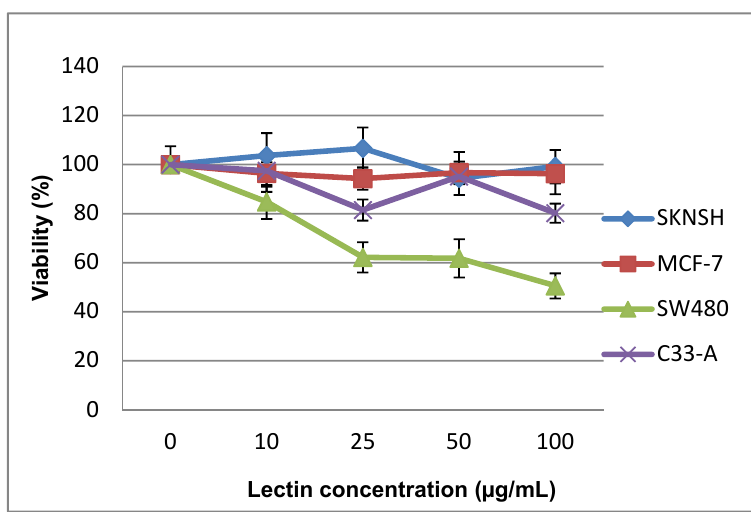
Figure 2. Cytotoxicity of tepary bean lectin (TBL) toward SKNSH, SW480, MCF-7, and C33-A cells after 24 h of exposure employing the 3-(4,5-dimethylthiazol-2-yl)-2,5- diphenyltetrazolium bromide (MTT) cell assay. All values are expressed as mean ± SEM of three independent experiments.